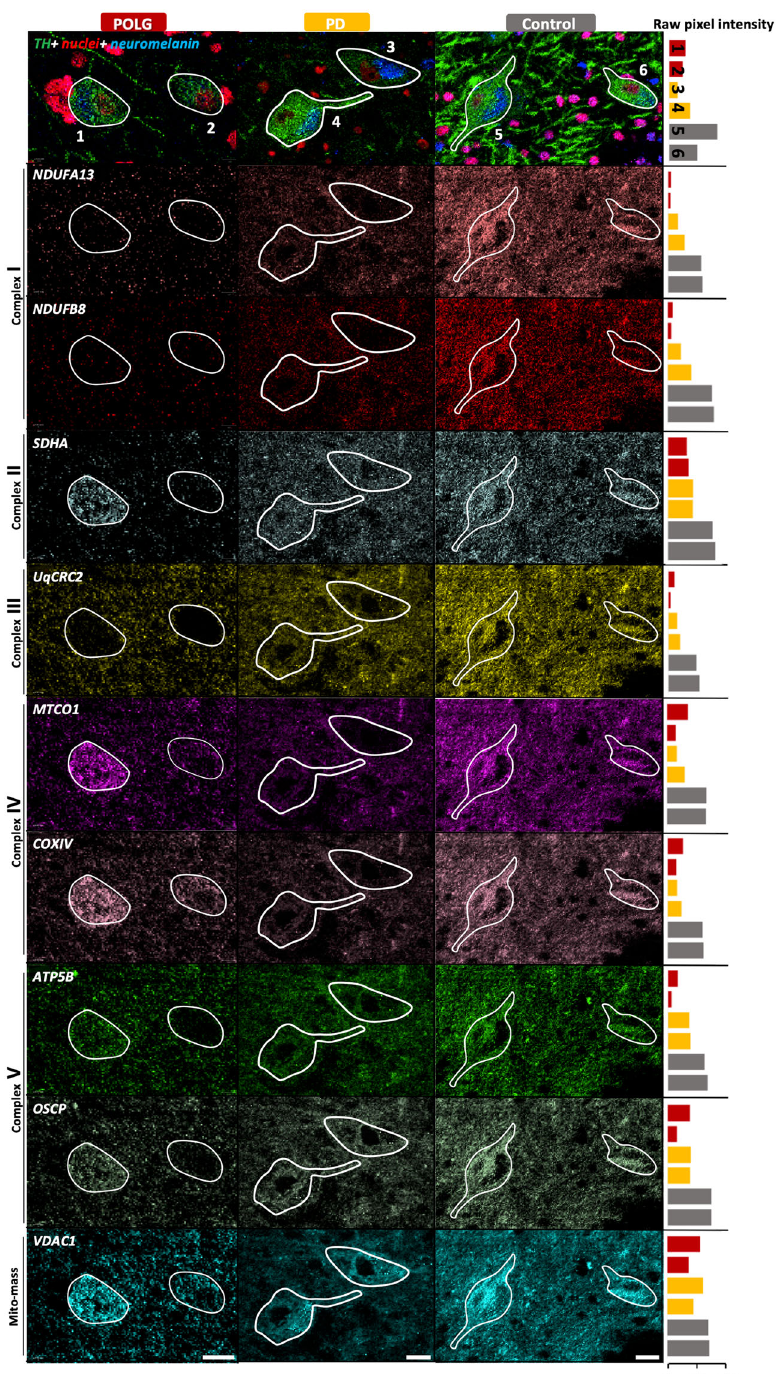
Fig. 2 IMC images of TH-positive SN neurons. The signal from eight OxPhos complex subunits and a mitochondrial outer membrane protein (VDAC1) as mitochondrial mass marker were pseudocoloured to highlight mitochondrial protein expression. Representative images were selected from POLG02 (female, 23 years), PD02 (male, 70 years) and Con01 (female,18 years). Nuclei (red) are labelled by a Histone H3 antibody, neuromelanin (NM, navy) is visualised via the signal from Ir-intercalator binding. Each individual neuron was outlined based on TH-positive staining and intracellular presence of a nucleus and NM signal. Bar charts include to the right of each row of images illustrate the comparison of the raw mean pixel intensity per neuron, and the numbers on the bars refer to the neuronal number in the corresponding images (red- POLG; yellow-PD; grey-control). Scale bar, 20